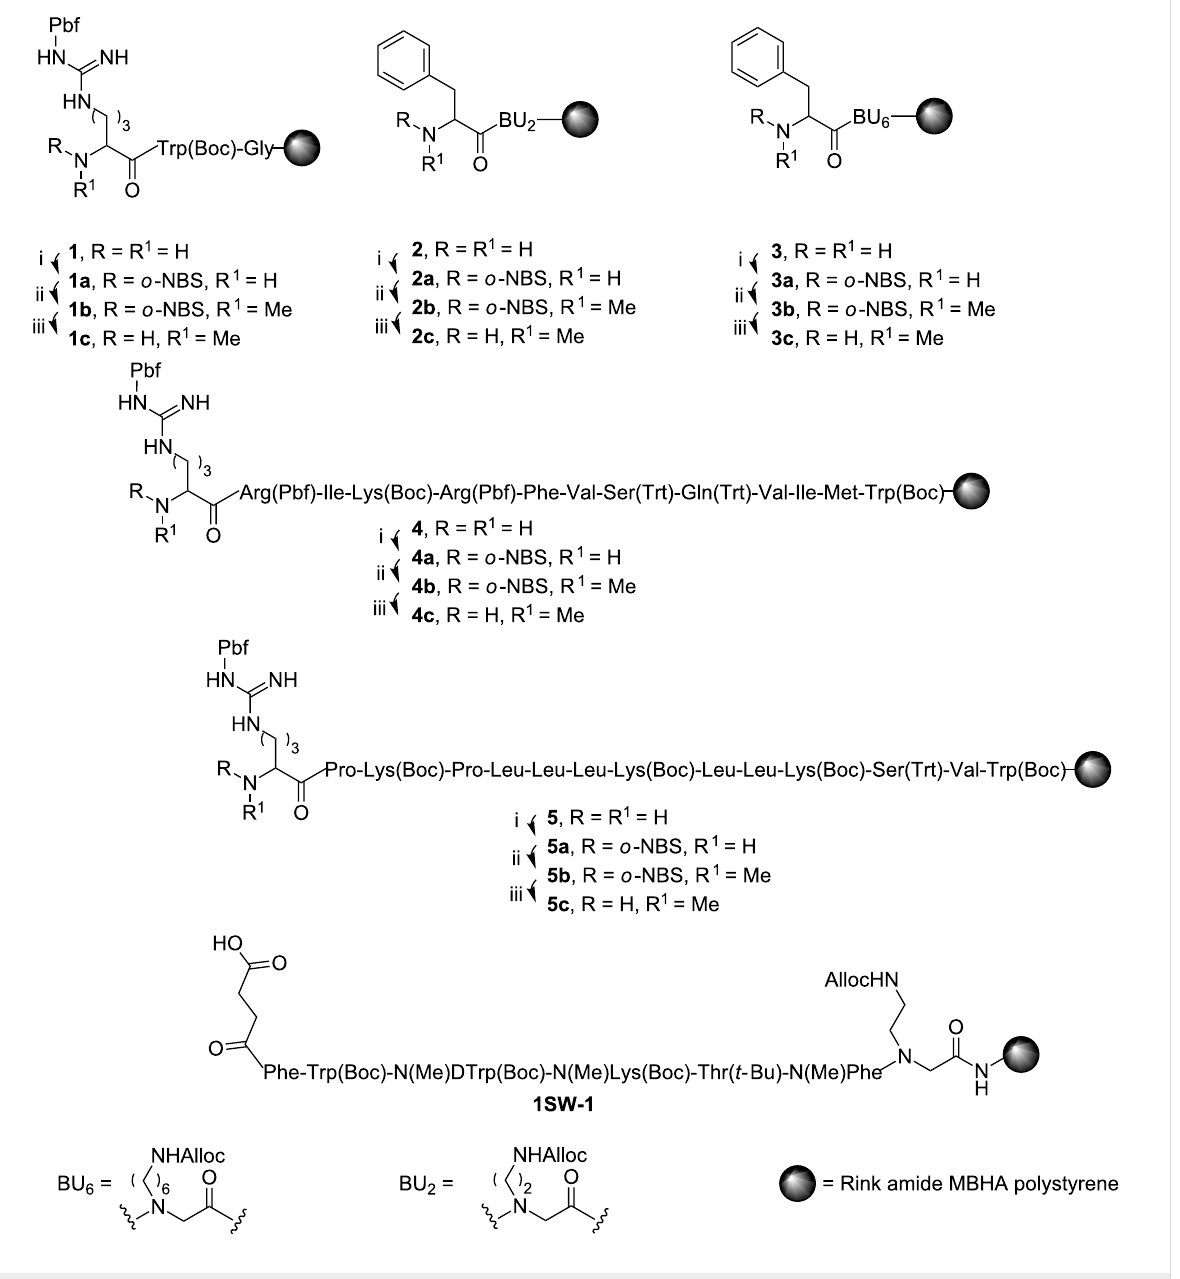
The effect of reaction time on conversion was evaluated by in- creasing the reaction time from 15 minutes to over 12